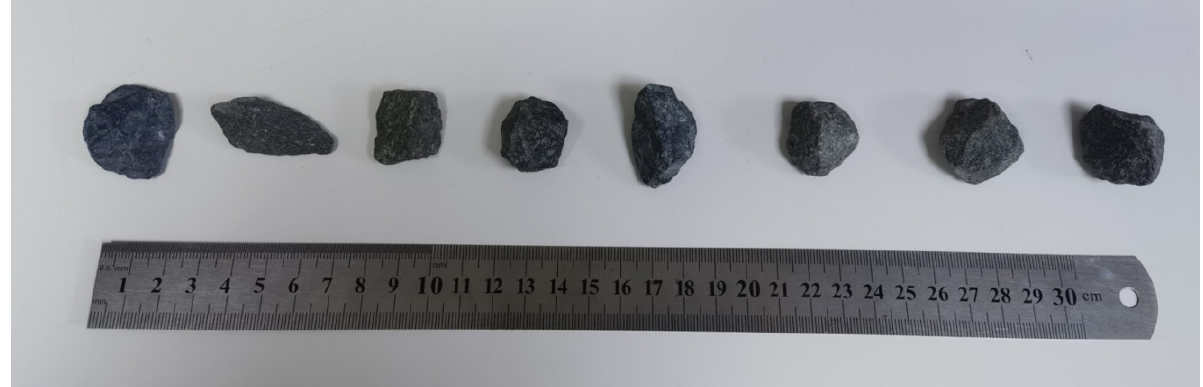
Figure 3. Original coarse aggregate.